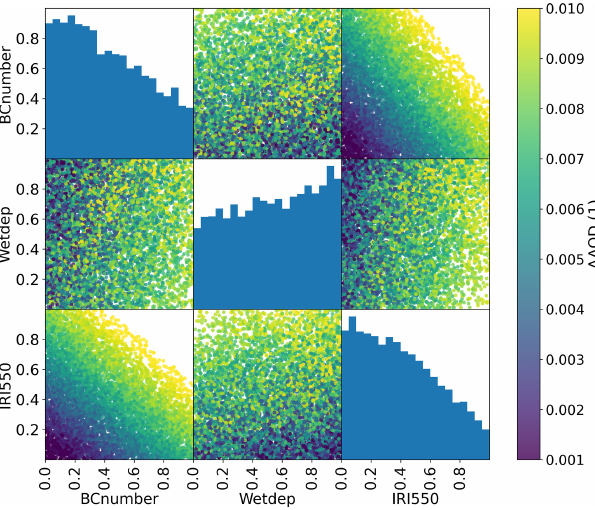
Figure 3. The posterior distribution of parameters representing the plausible space of parameters for the example perturbed pa- rameter ensemble experiment having been calibrated with a GP against observed absorbing aerosol optical depth measurements from AERONET. The diagonal histograms represent marginal dis- tributions of each parameter while the off-diagonal scatterplots rep- resent samples from the joint distributions. The colour represents the (average) emulated AAOD for each parameter